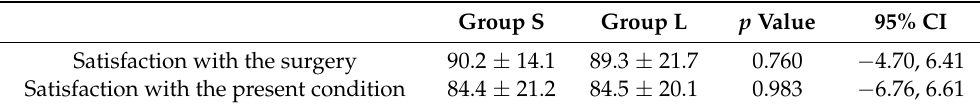
Data are shown as the mean ± standard deviation; CI, Confidence Interval; ODI, Oswestry Disability Index; VAS, Visual Analog Scale *, p < 0.05; In group S, the duration of symptoms (DOS) was <12 months; in group L, the DOS was ≥ 12 months.